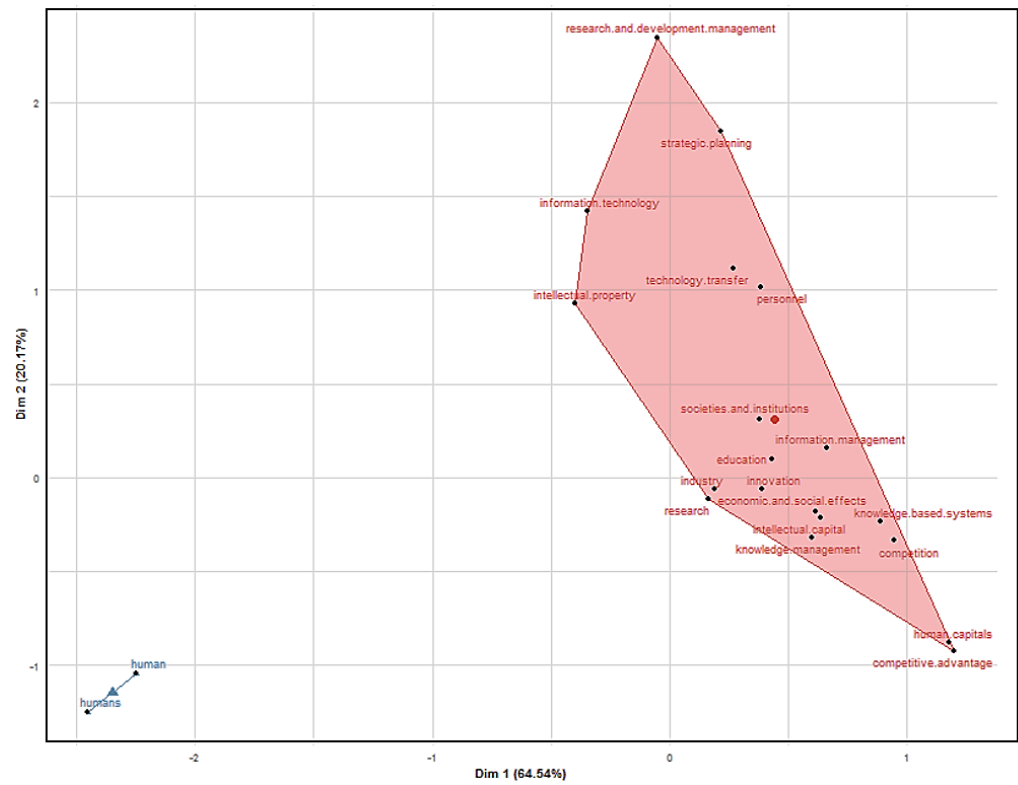
Figure 7. Keyword clusters by appearance.